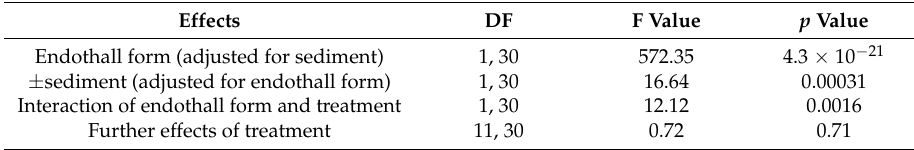
Table 4. Analysis of variance for treatment effects on endothall isomer-1 concentration at day-0. DF = Degrees of